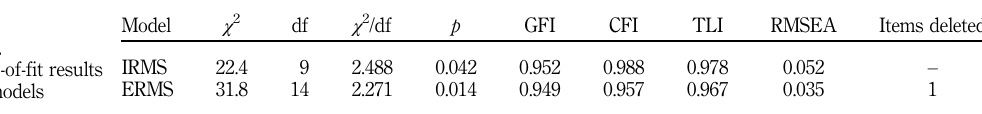
Table V. Goodness-of-fit results for role models